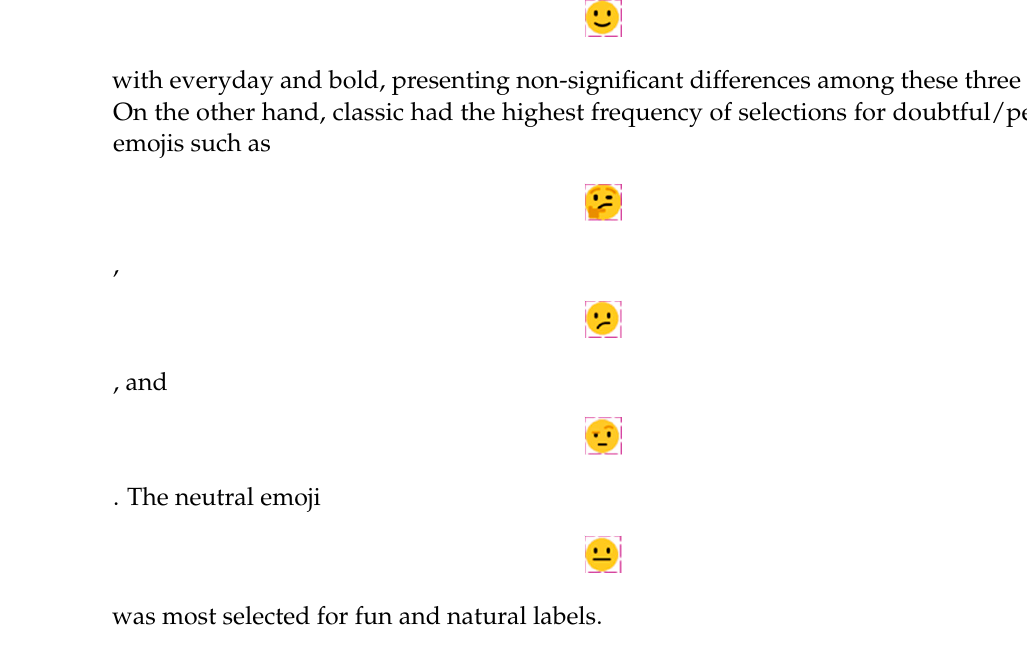
Table 4. Mean ± standard error values from the acceptance test for the six different label samples (Figure 1).